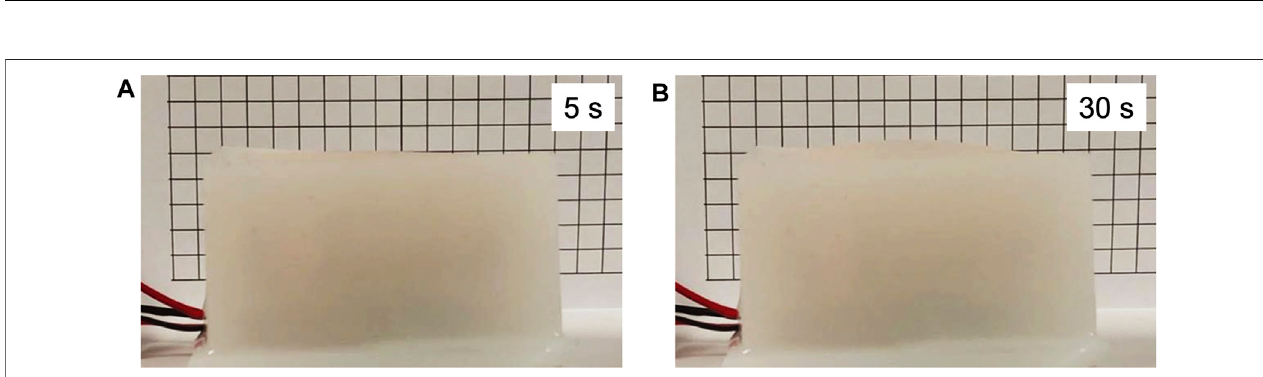
FIGURE7 |(A) Thefabricatedstructureis placed infront ofa grid with lines separated by5 mm. (B) The image shows the in fl atedstructureafter 30 sofactuation.